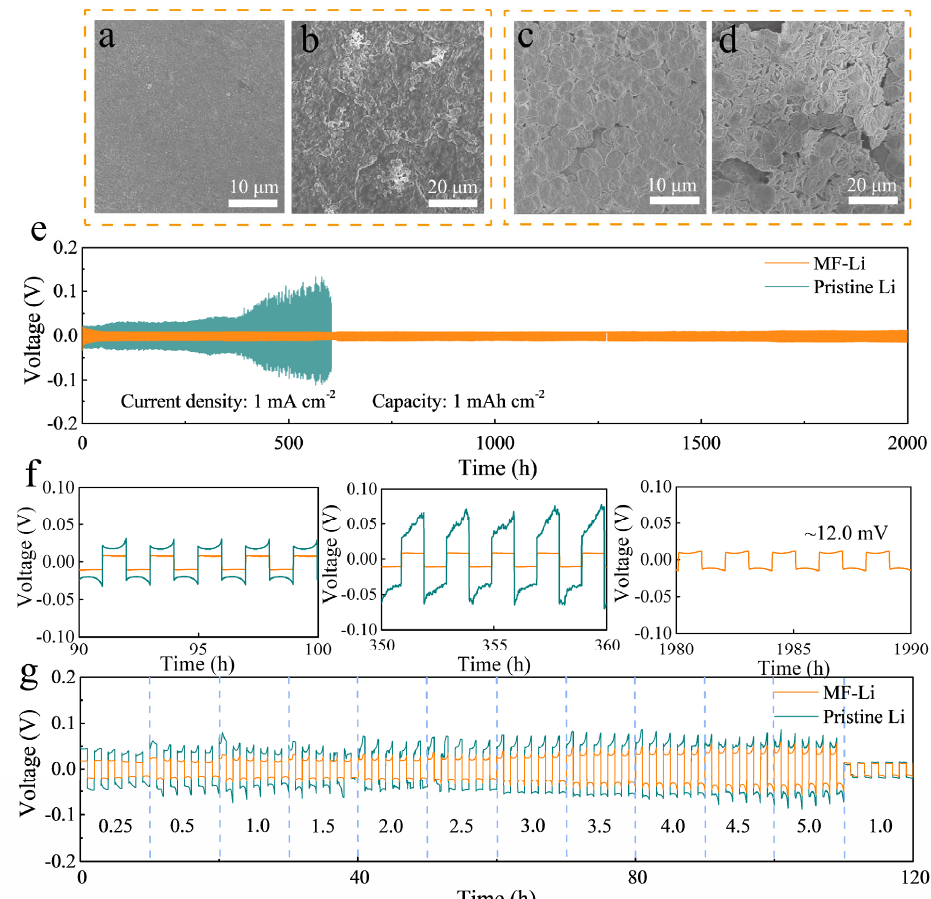
Figure 4. The surface morphology of ( a ) the MF-Li and ( b ) the pristine Li anode after plating at the current density of 0.5 mA cm − 2 for 2 h. ( c , d ) Top view SEM images of ( c ) the MF-Li anode and ( d )